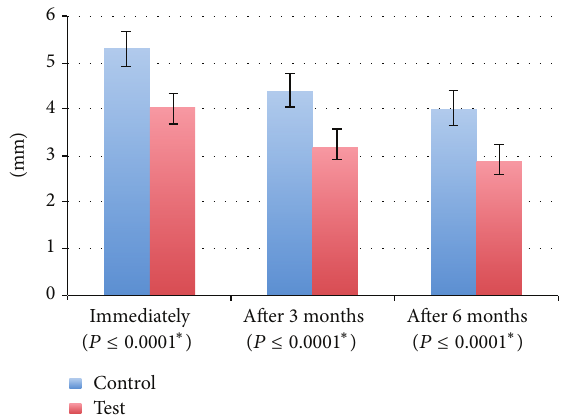
Figure 5: Mean and standard deviation for bone loss (millimeters). ∗ : statistically significant at 𝑃 ≤ 0.05